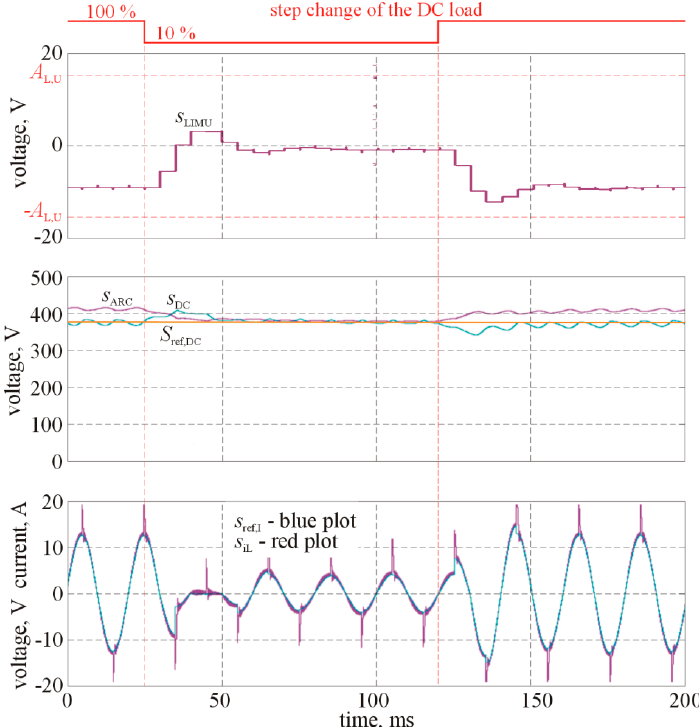
Figure 12. Waveforms in the PSP in response to step changes in the DC load. The upper plot shows the signal at the output of the voltage regulator, the middle plot shows signals related to the DC circuit, and the lower plot shows the reference signal for the current regulator and PSP input current.